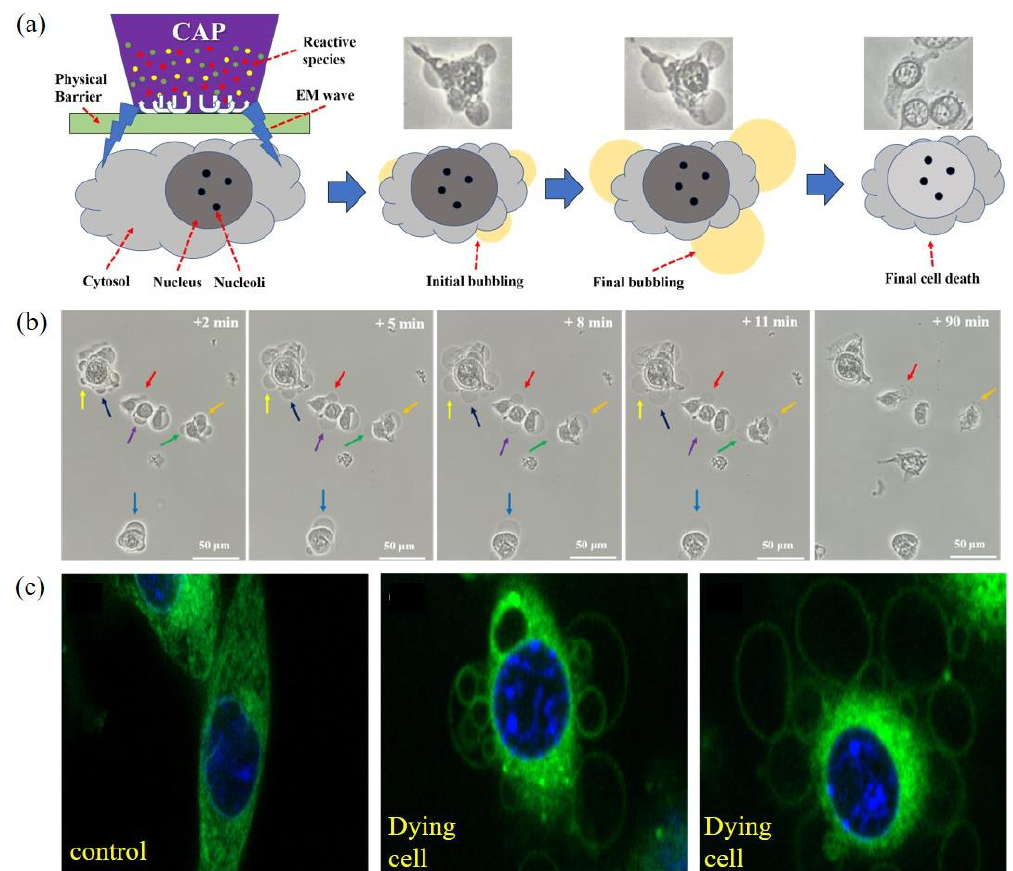
Figure 5. Direct observation of necrosis on the physically based CAP-treated melanoma cells (B16F10). ( a ) Schematic illustration. ( b ) A time-lapse observation of bubbling. ( c ) The fluorescent imaging of the treated B16F10 cells. Microtubules (green) and DNA (blue) were stained using BioTracker 488 green microtubule cytoskeleton dye and Hoechst 33342, respectively [20].